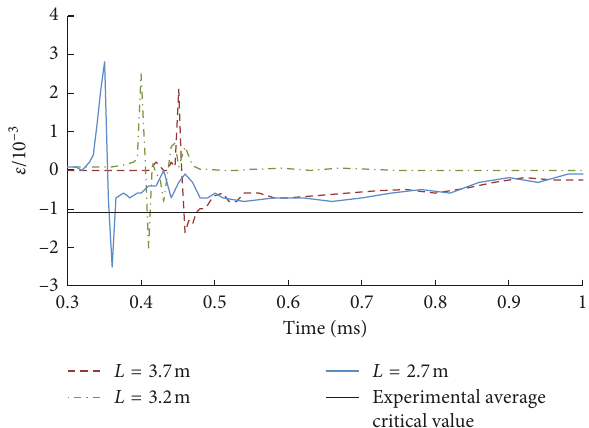
Figure 15: Strain evolution around the free surface of the empty hole. Note that Compression strain is positive and tension strain is negative.